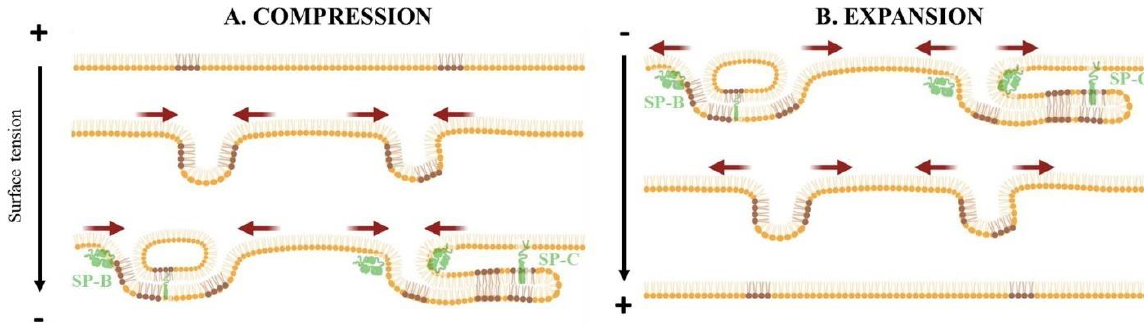
Figure 3. Sketch of the different remodeling processes occurring during compression-expansion cycles of the alveolar cavity. Reprinted from Da Silva et al. [32] , with permission from Elsevier, Copyright 2021.